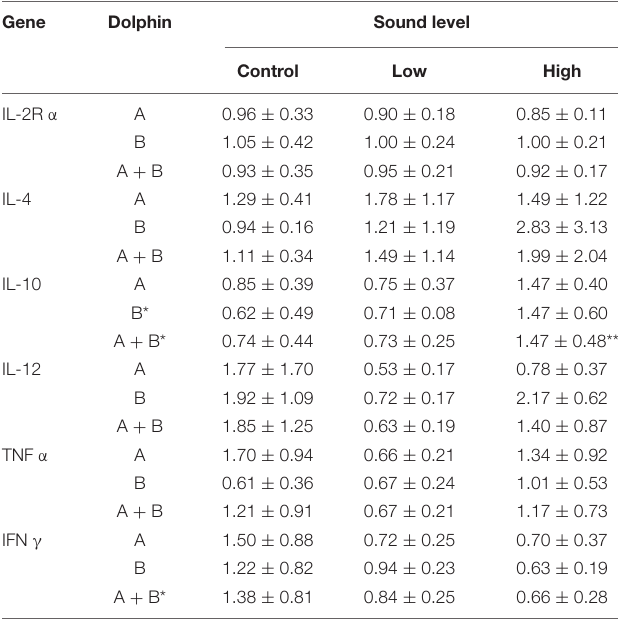
TABLE 3 | Results of Kruskal-Wallis tests with post-hoc Dunn’s tests of the transcription ratio (mean ± SD) of post-exposure and pre-exposure